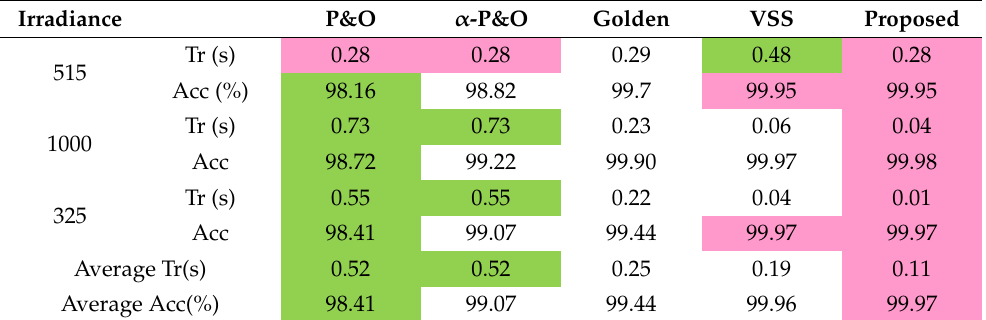
Table 7. Experimental results of five compared MPPT methods under varying irradiation